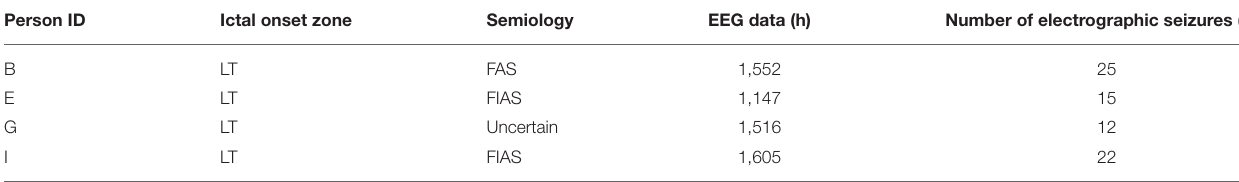
TABLE 1 | Epilepsy and data characteristics for each person.